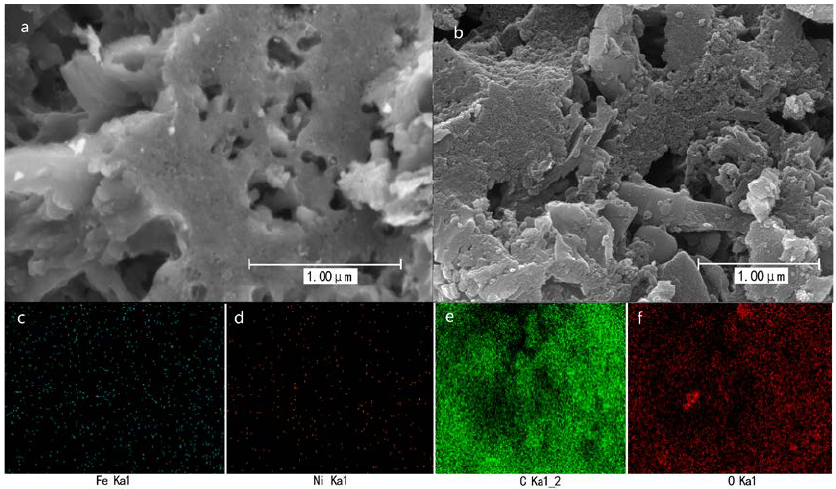
Figure 3. SEM micrographs: active carbon ( a ); Fe-Ni/MAC ( b ) and element mapping micrographs: iron ( c ); nickel ( d ); carbon ( e ); oxygen ( f ).